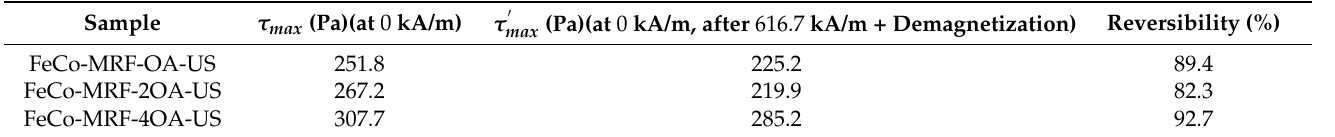
Table 6. Values of the yield stress measured at the maximum shear rate (600 s − 1 ) under different applied magnetic field conditions, for the -US fabricated fluids with different oleic acid surfactant concentrations studied.